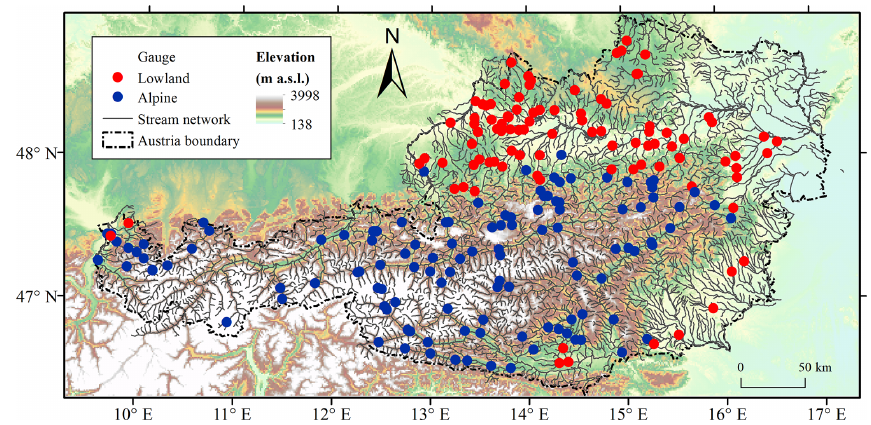
Figure 1. Topography of the study region and location of 94 lowland (red symbols) and 119 alpine (blue symbols) catchments. Table 2. Statistics of the climatic attributes of the 94 lowland catchments and 119 alpine catchments given with the abbreviation, unit, minimum, maximum, and median. The standard deviations refer to the spatial variability within each catchment. Attribute Abbr. Unit Lowland Alpine (mean elevation under 900ma.s.l.) (mean elevation over 900ma.s.l.) Min. Max. Median Min. Max. Median Mean annual precipitation MAP mm 728.13 Mean air temperature MAT ◦ C Standard deviation of MAT